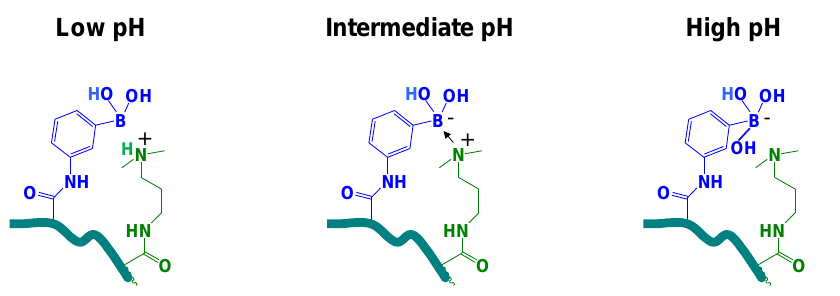
Figure 6. Acid-base equilibrium of PBA moiety in DMP- co -MPBA- co -AAm